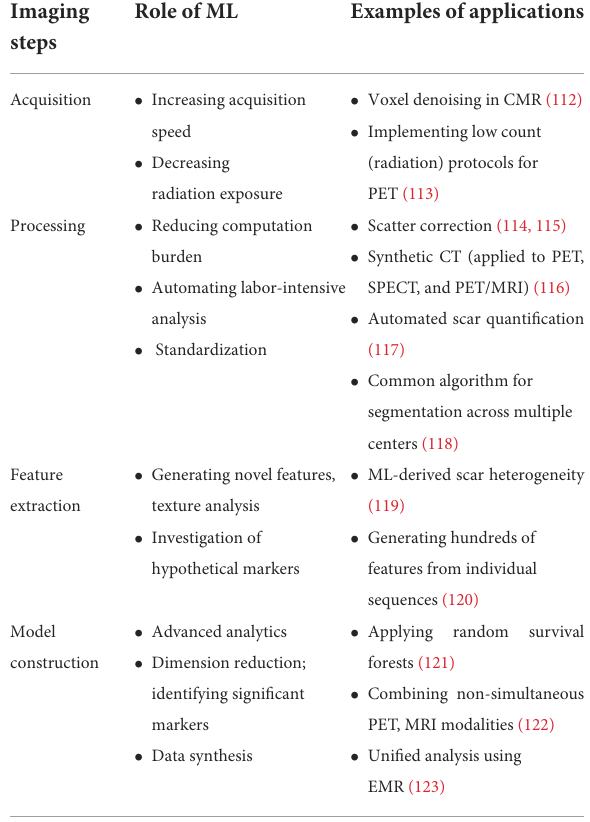
TABLE 2 Incorporation of machine learning into advanced